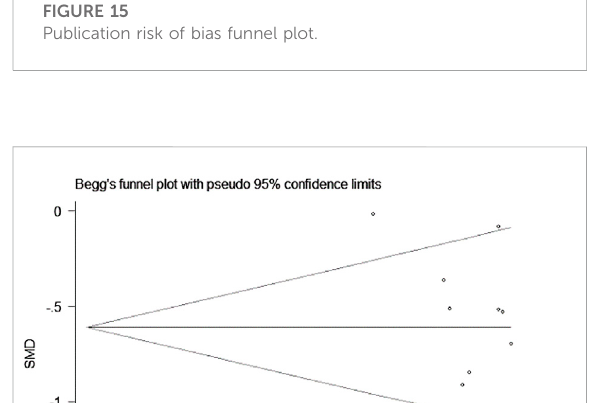
FIGURE 15 Publication risk of bias funnel plot.